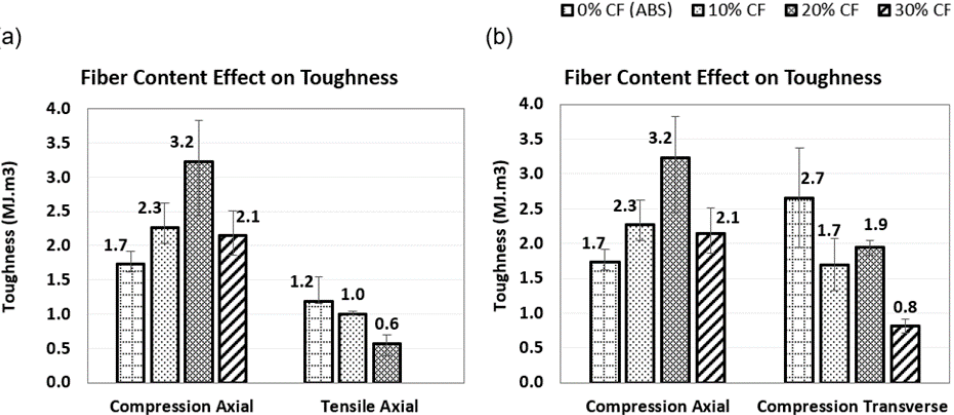
Figure 7. Fiber Content Effect on the Compressive Toughness of AM Fabricated CFRP Composites ( a ) Axial versus Transverse Compression ( b ) Axial Compression versus Axial Tensile .